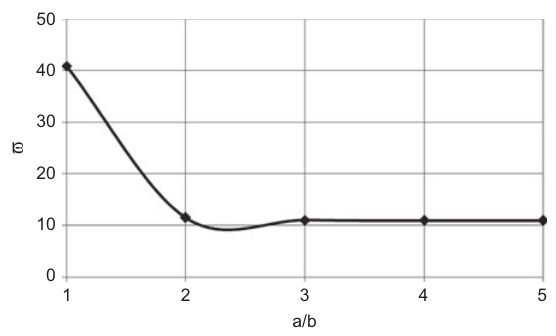
Figure 8 Effect of plate aspect ratio on the fundamental frequency.